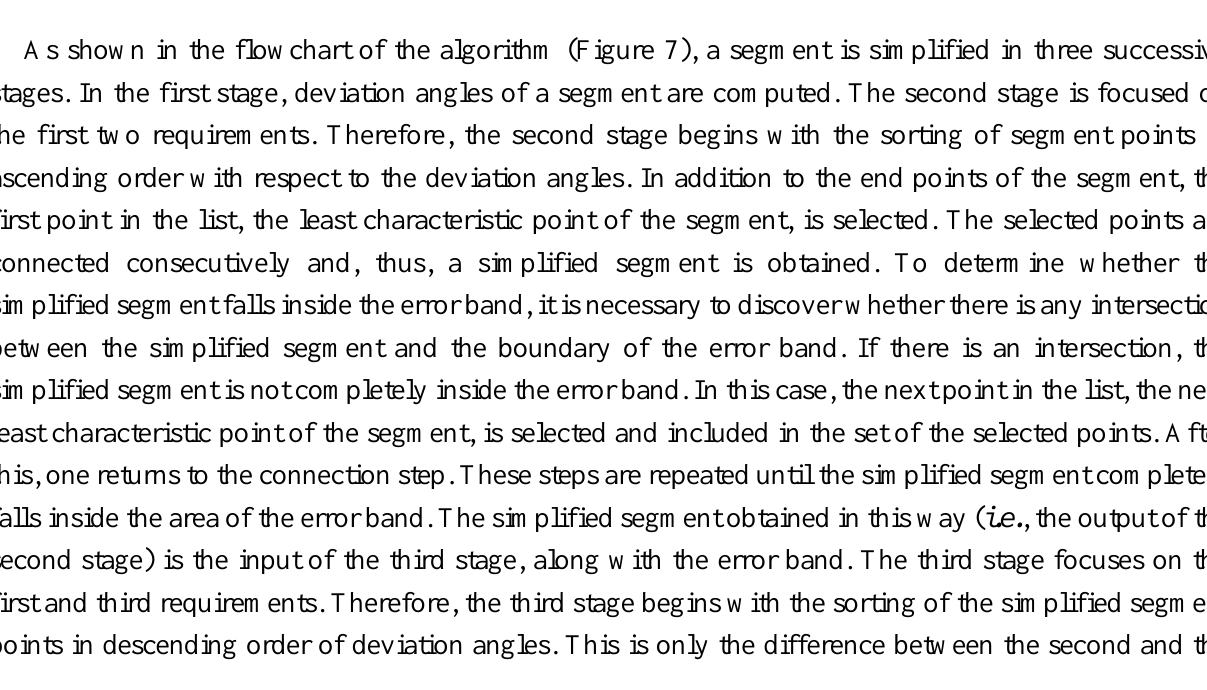
Figure 7. Flowchart of the Segment Simplify